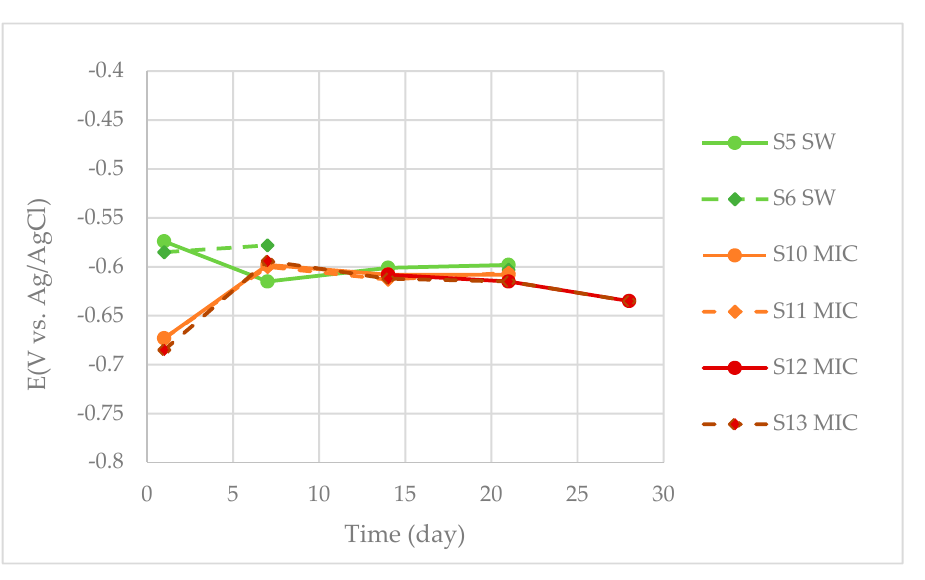
Figure 2. Polarization curves for the polished samples in artificial seawater (open to air) at 20 °C.